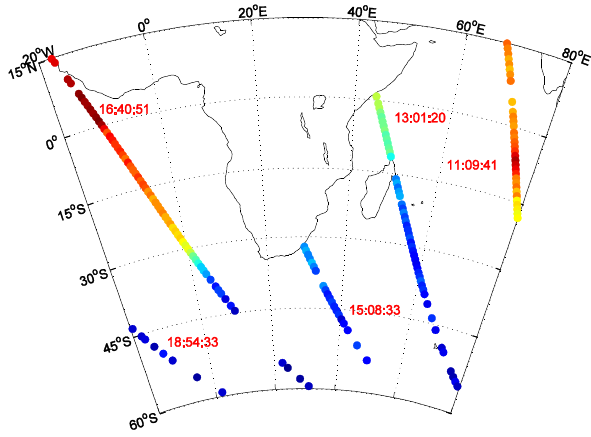
Figure 9 Changes in the VTEC data obtained by the Jason-1 satellite in the descending orbit from 13 to 18 May. Figure 8 Changes in the VTEC data obtained by the Jason-1 satellite in the ascending orbit from May 13 to 18.